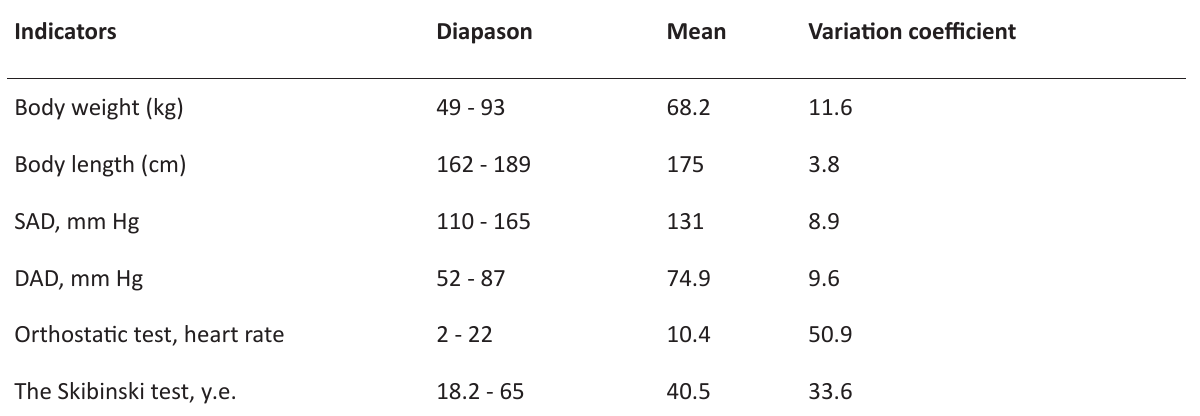
Table 7. Typical (95%) ranges of indicators change Indicators Diapason